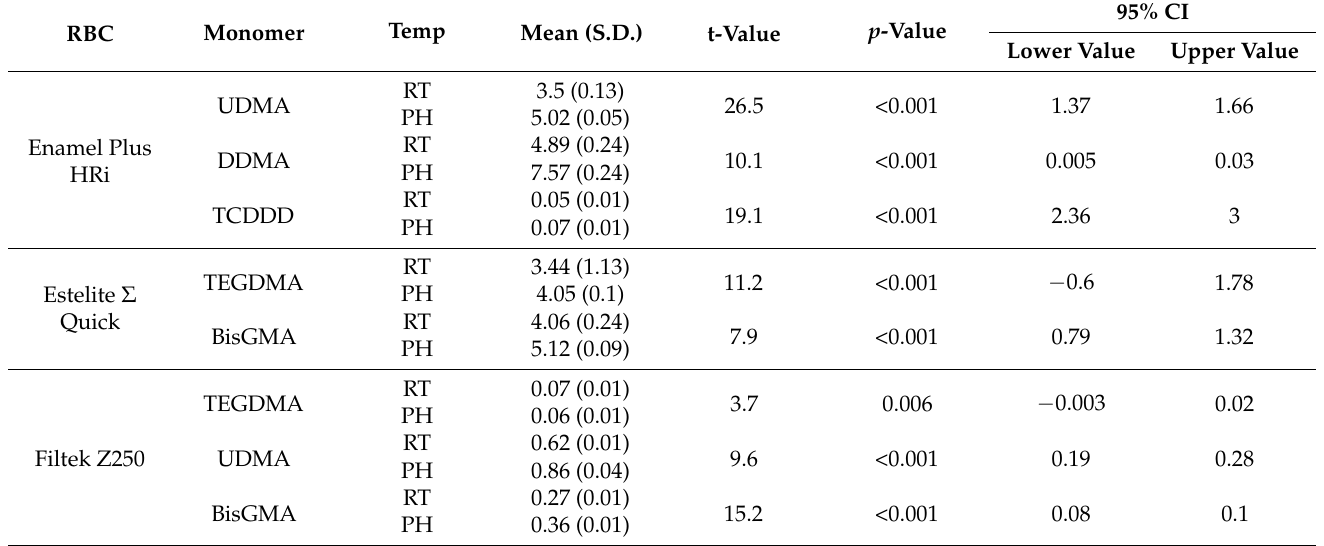
Table 1. Differences in mean values of eluted monomers (nmol/1 mg RBC) between room-temperature (RT) and pre-heated (PH) resin-based composites. Data are provided using a two-tailed independent t -test .